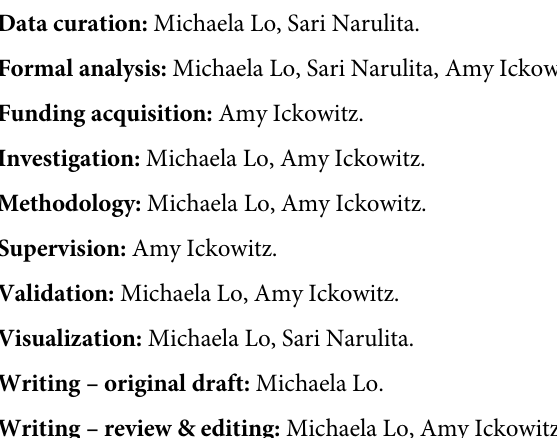
S1 Fig. Pseudo R 2 and z-statistics for all measures of forest cover. See Table 1 for definitions of forest cover